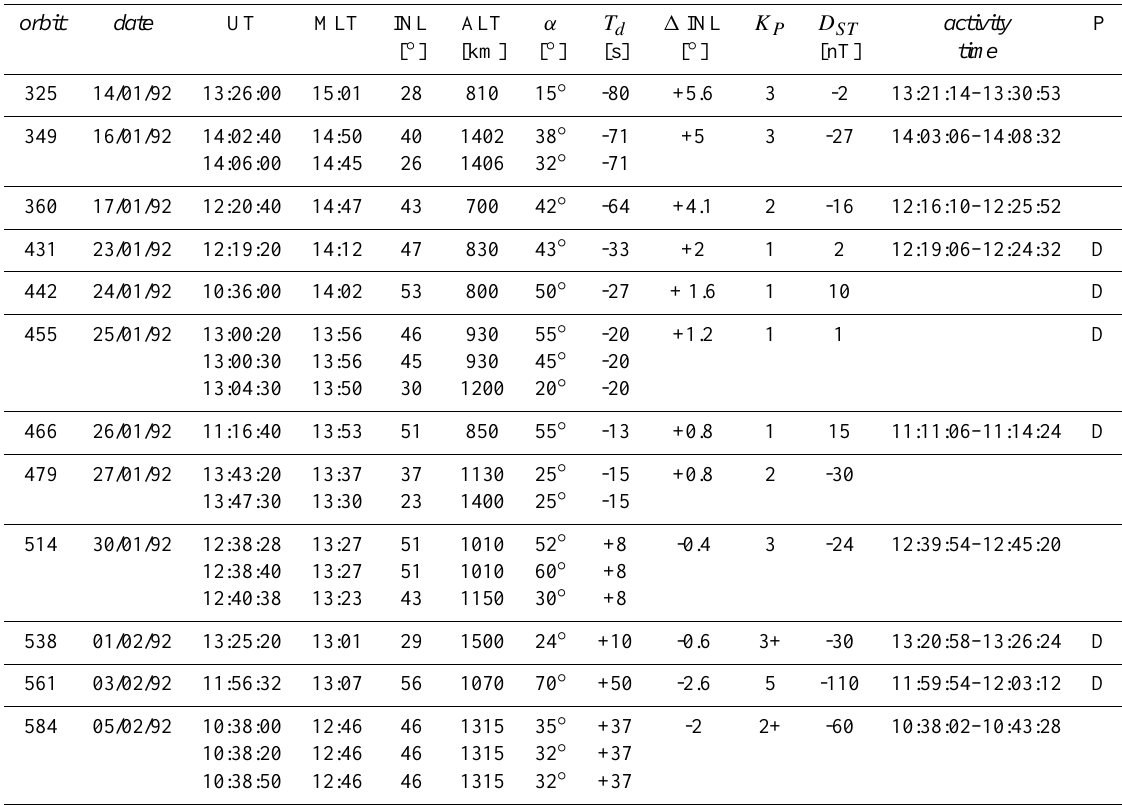
Table 1. Conditions for the electron bursts